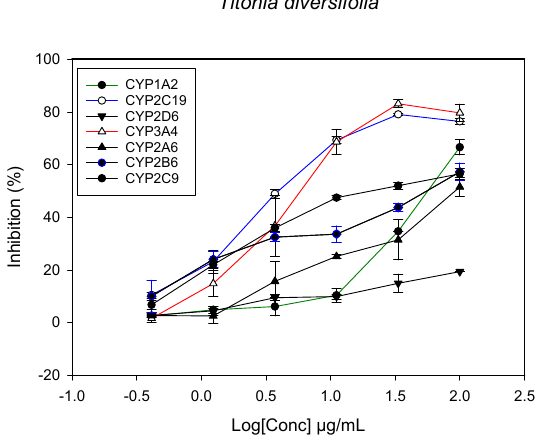
Figure 7. The inhibitory effect of graded concentrations of the extracts of T. diversifolia on the metabolic activity of cytochrome P450 enzymes.